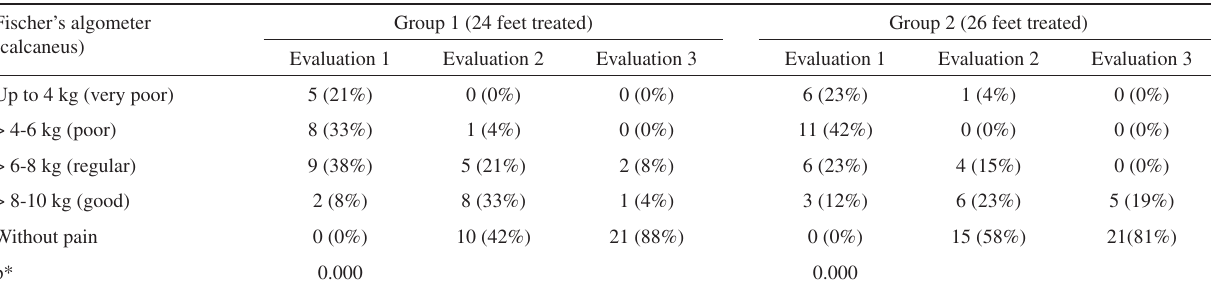
Table 7 – Patient distribution according to intensity of pain in gastrocnemius obtained by Fischer’s algometer in Groups 1 and 2 before and after treatment